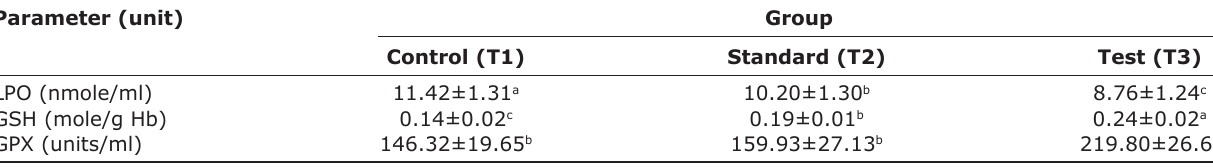
Mean values with dissimilar superscripts within row vary significantly (p≤0.05). LPO=Lipid peroxidation, GSH=Glutathione, GPX=Glutathione peroxidase, Hb=Hemoglobin, CSE=Extract of leaves of Cassia